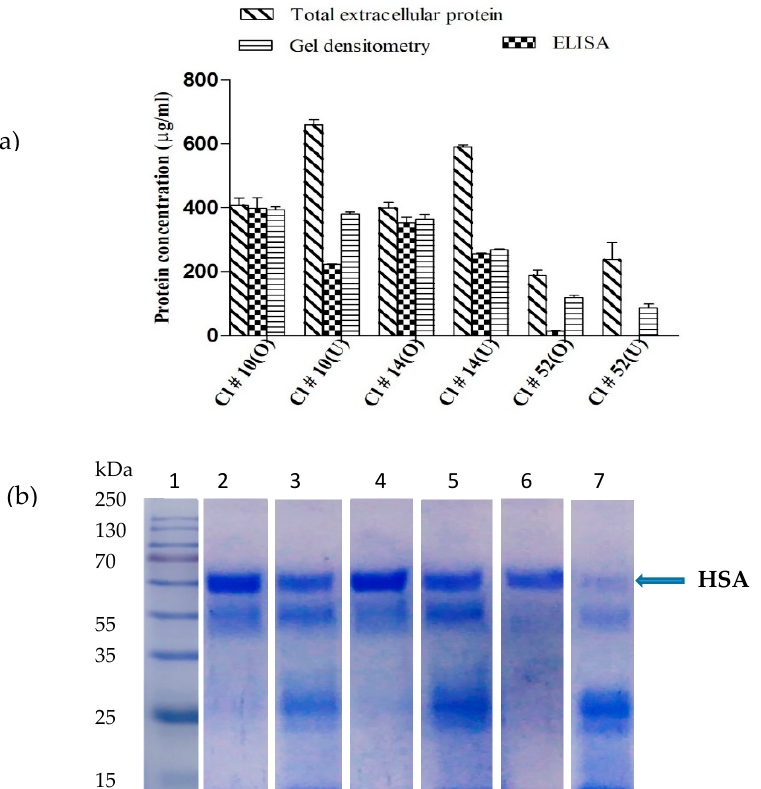
Figure 5. ( a ) Total extracellular protein production, ELISA, gel densitometry analysis of the secreted HSA in two-copy Clone #s 10, 14, and in single-copy Clone # 52 under optimized (O) and unoptimized (U) media conditions. ( b ) SDS-PAGE analysis of the culture filtrate from clones mentioned in ( a ). Lane1- Protein Ladder, Lanes 2, 4- Clone #s 10, 14, under optimized conditions and Lanes 3, 5 on unoptimized medium. Lanes 6, 7 show the extracellular protein profile of Clone # 52 under optimized and unoptimized condition, respectively.